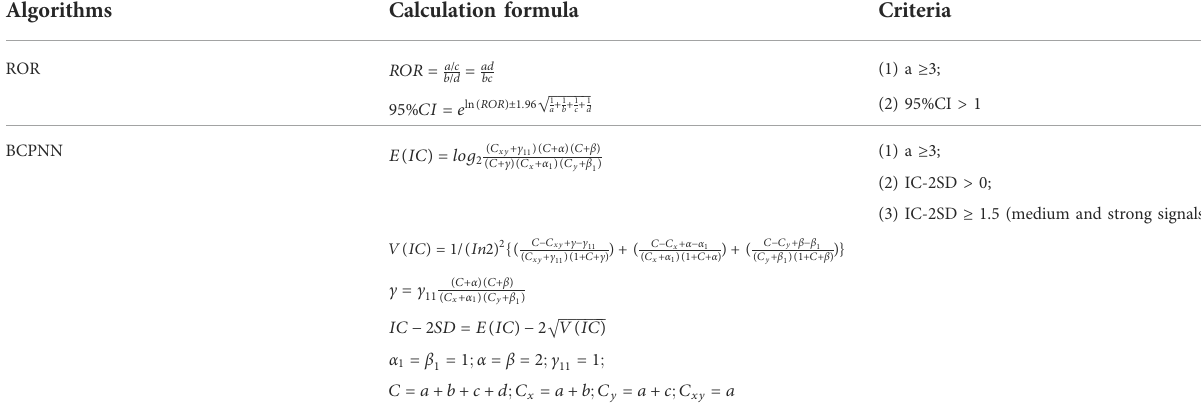
TABLE 2 Principle of dis-proportionality measure and standard of signal detection.